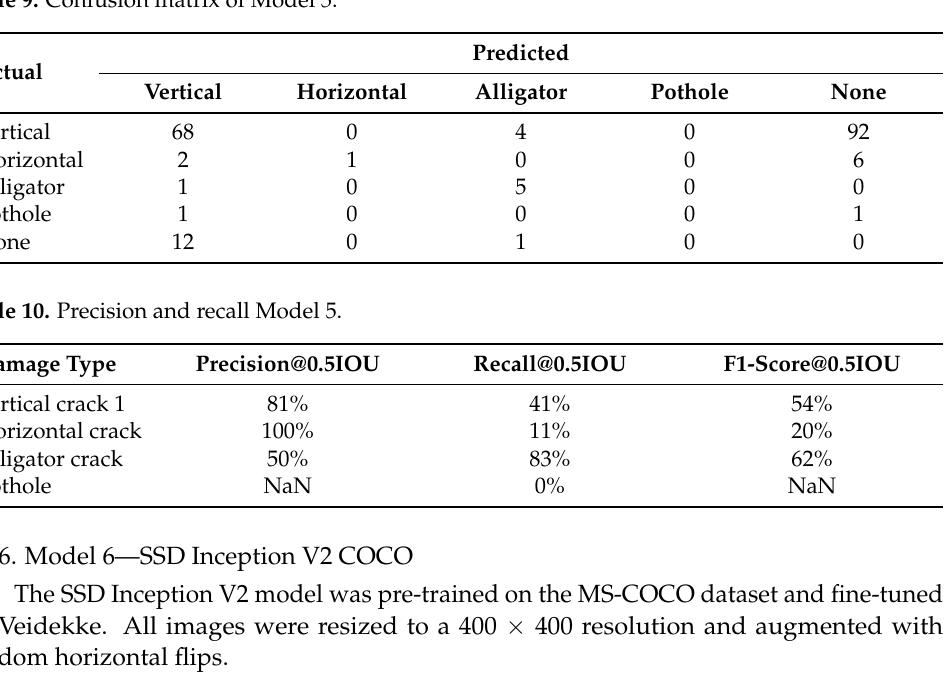
Table 9. Confusion matrix of Model 5.